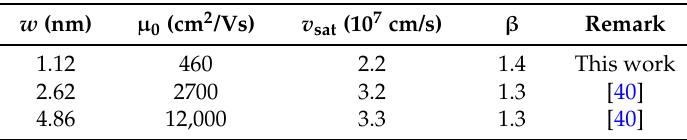
Table 1. Parameters for the Caughey–Thomas fit of the v - E characteristics for three ac 3 p + 1 graphene